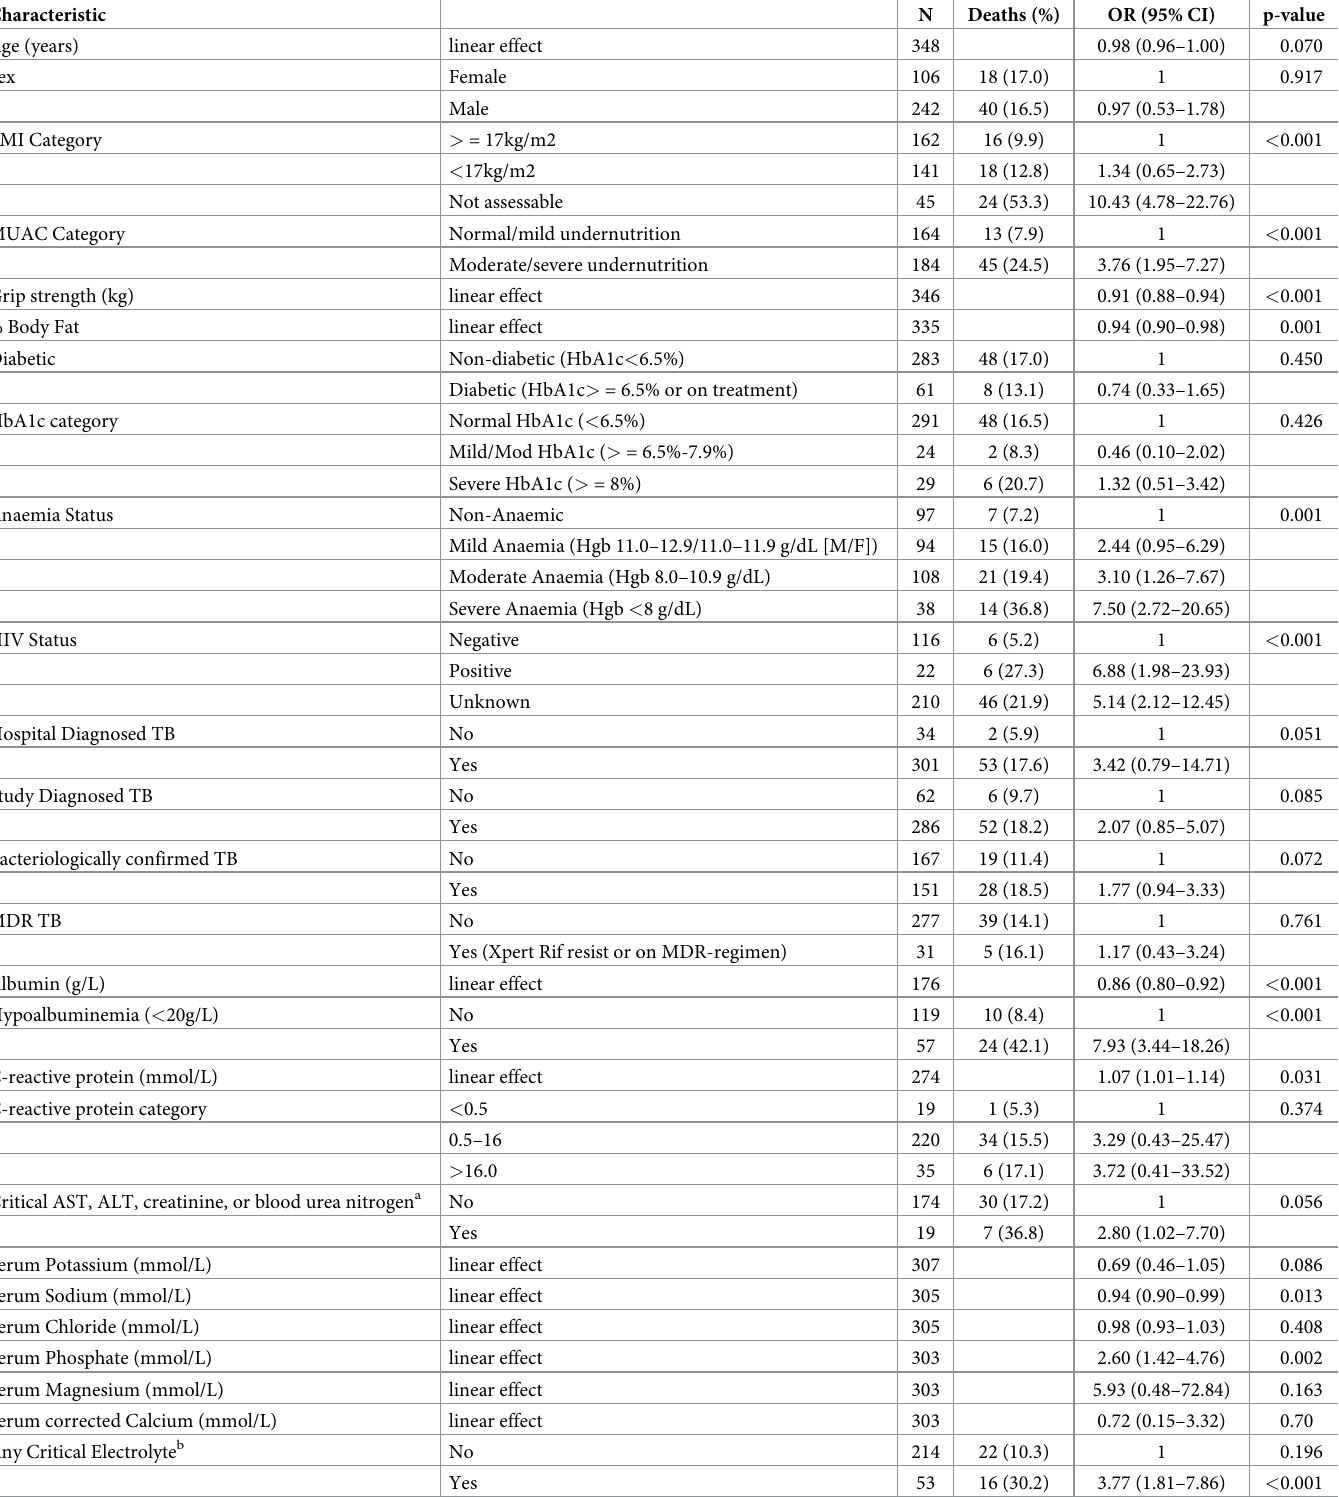
Table 2. Univariable associations with D3-D28 mortality (primary analysis population, N = 348).